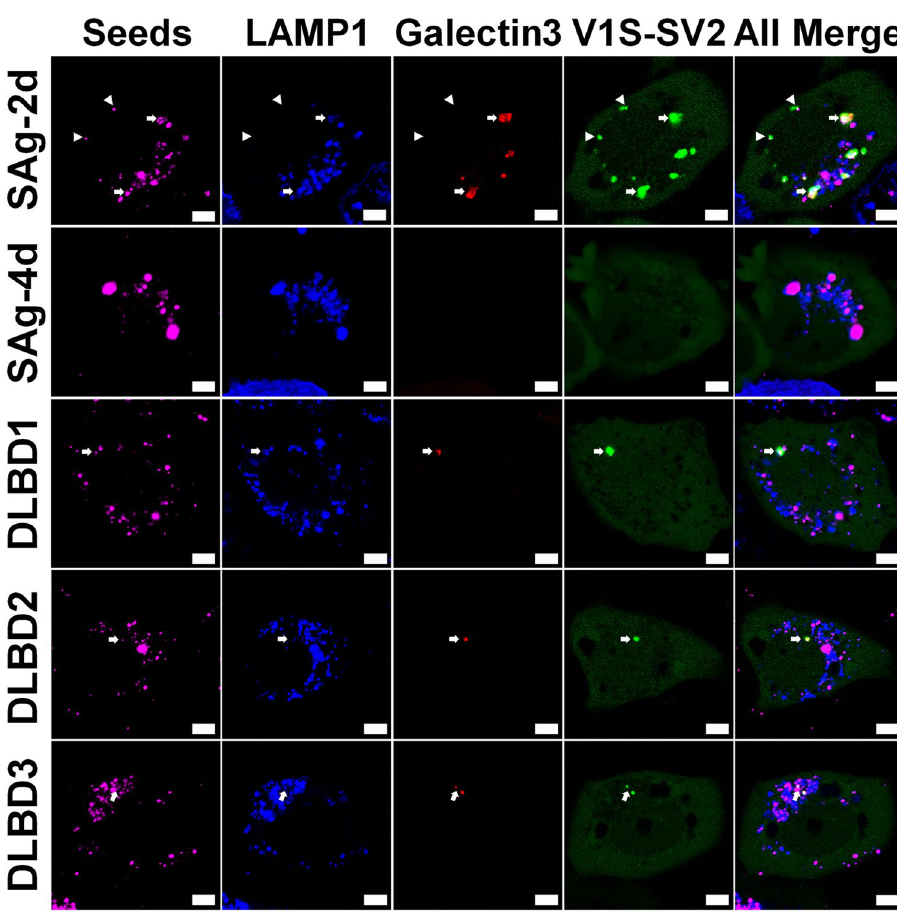
Figure 5. Endo-lysosome rupture is involved in endocytosis-mediated seeding. H4/V1S-SV2/ LAMP1-eCFP/ mCherry-Galectin-3 cells were treated with DyLight ® 650 labeled SAg-2d, SAg-4d, or immunoprecipitation- isolated α S from brain lysates of 3 different DLBD cases (DLBD1, DLBD2 and DLBD3) for 2 days followed by imaging under confocal microscopy. Arrows denote α S seeds and their induced α S inclusions associated with endo-lysosomes and Galectin-3 accumulation. Arrowheads denote α S seeds and their induced α S inclusions that are not associated with endo-lysosome and Galectin-3. Scale bar: 5 µ m. Table 1. Quantification of the seeds associated with different structures in different groups.